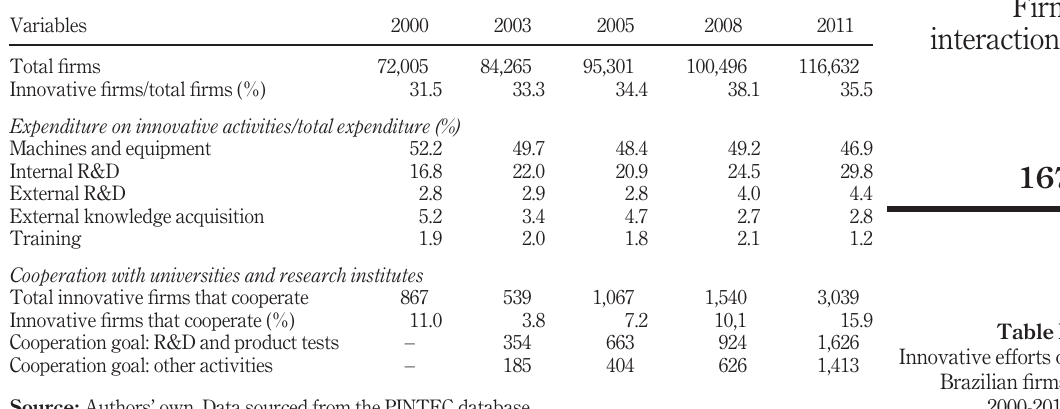
Table I. Innovative efforts